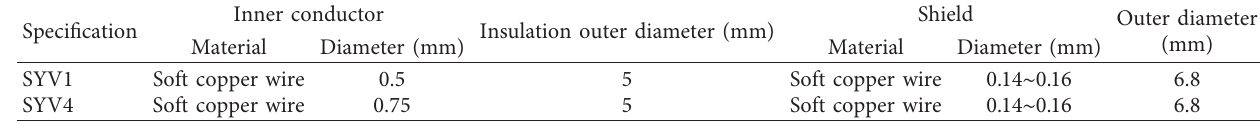
Table 1: Structural dimensions of syv1 and syv4 coaxial power